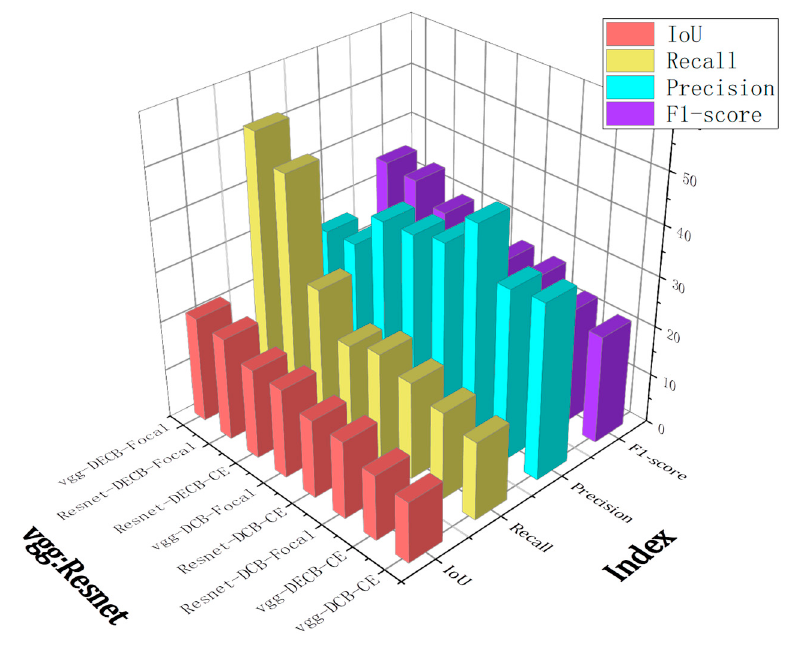
Figure 12. Comparison chart of condition combinations and evaluation indicators for forest fire burning area segmentation results corresponding evaluation indicators.